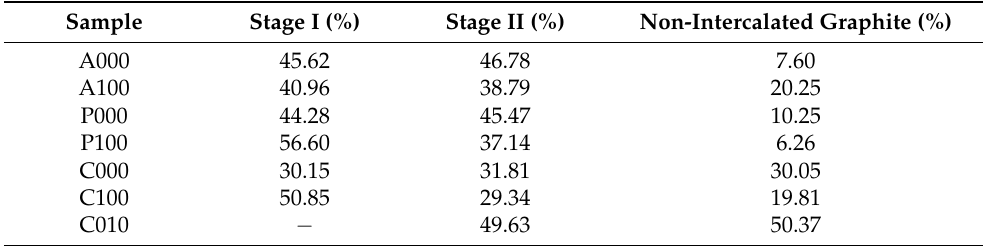
Figure 5. Raman spectra of GBS products obtained using CrO 3 oxidizing agent ( a ), G band frequencies ( b ), and 2D band frequencies ( c ). Table 2. Amount (%) of stage I, stage II, and non-intercalated graphite phases in GBS samples determined according to the intensities of the G1, G2, and G peaks, respectively.